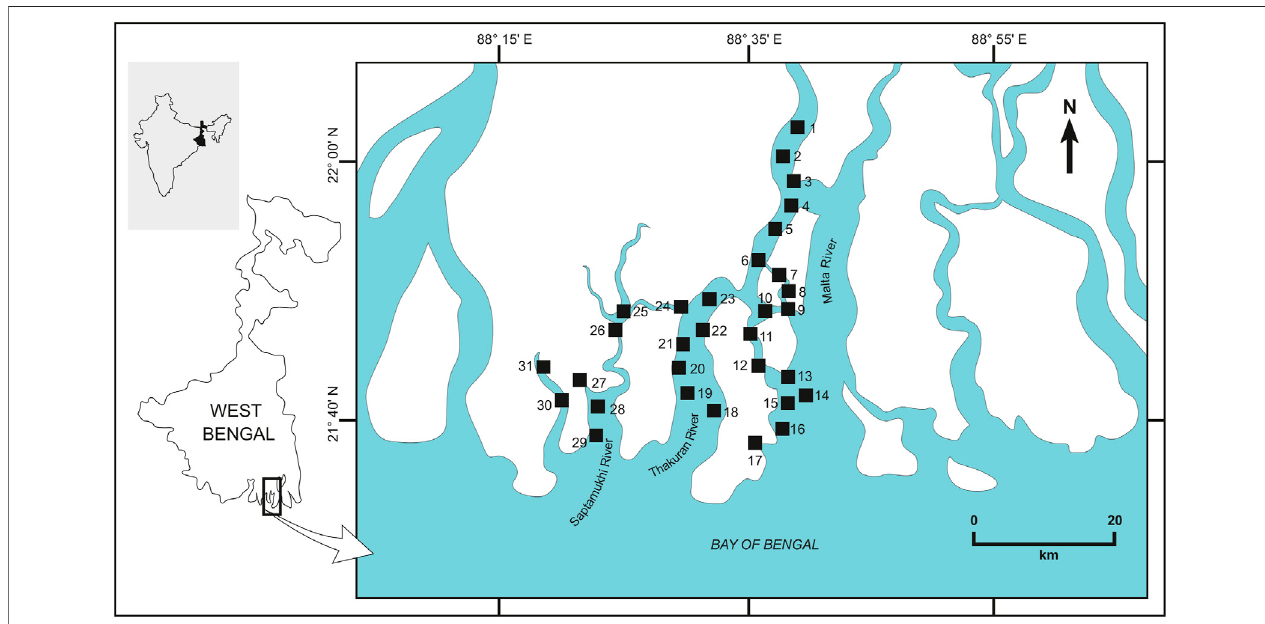
FIGURE 1 | Map of the study area showing points off observation in the Indian Sundarban